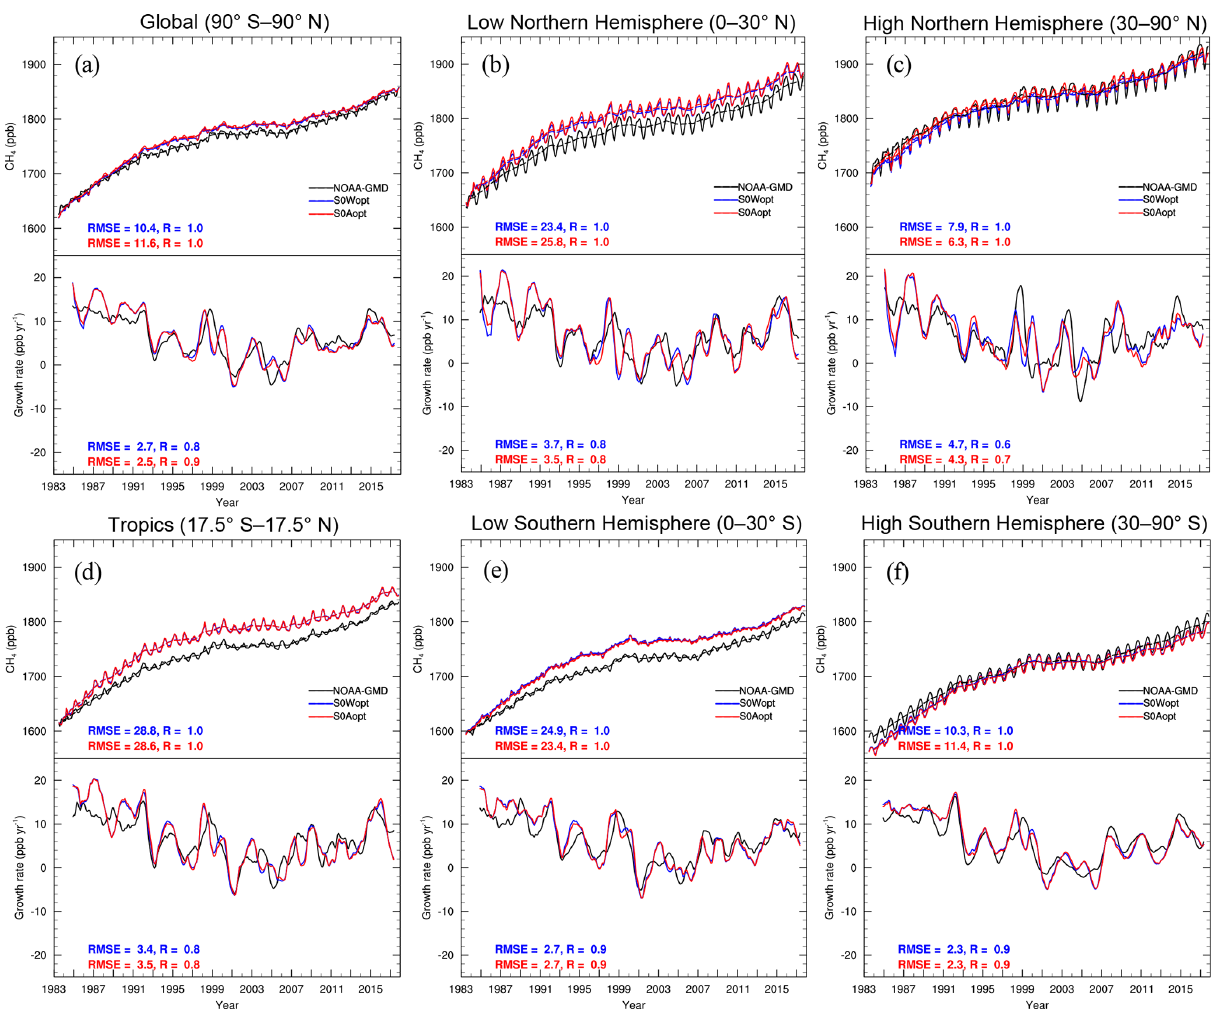
Figure 4. Comparison of GFDL-AM4.1 simulated methane concentrations and growth rates with NOAA GMD surface observations. For the upper plot in each panel, the dashed line represents smoothed trends (i.e., 12-month running mean) from deseasonalized monthly data. A meridional curve (Tans et al., 1989) was fitted through NOAA GMD site observations to get the latitudinal distribution of methane. A function fit consisting of yearly harmonics and a polynomial trend, with fast Fourier transform and low-pass filtering of the residuals is applied to the monthly mean methane DMF (Thoning et al., 1989; Thoning, 2019) to approximate the long-term trend. For the lower plot in each panel, the growth rates are calculated from the time derivative of the dashed line in the corresponding upper